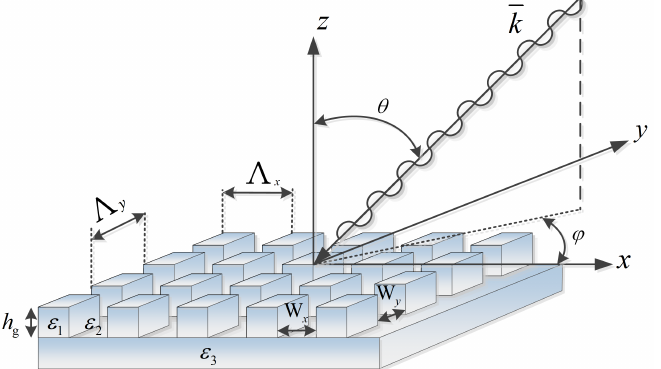
Figure 1. A schematic of a basic structure that comprises a 3D-cuboid-grating layer. The notations on the figure: Λ x;y , W x;y , h g , ε 1 , ε 2 , ε 3 , θ , and ϕ , are described in the